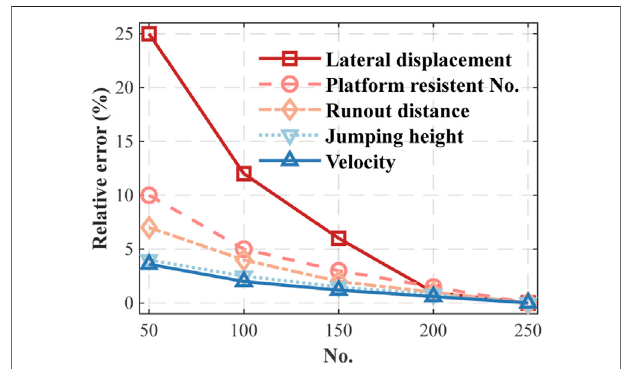
FIGURE 6 | Relationship between relative error and number of experiments.